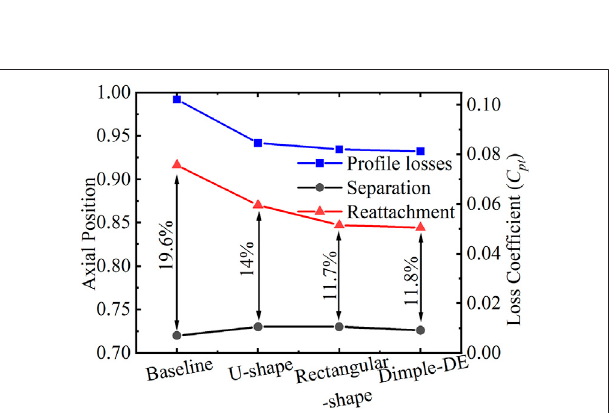
FIGURE 9 | Time- and spanwise-averaged shape factor distribution for various surfaces.